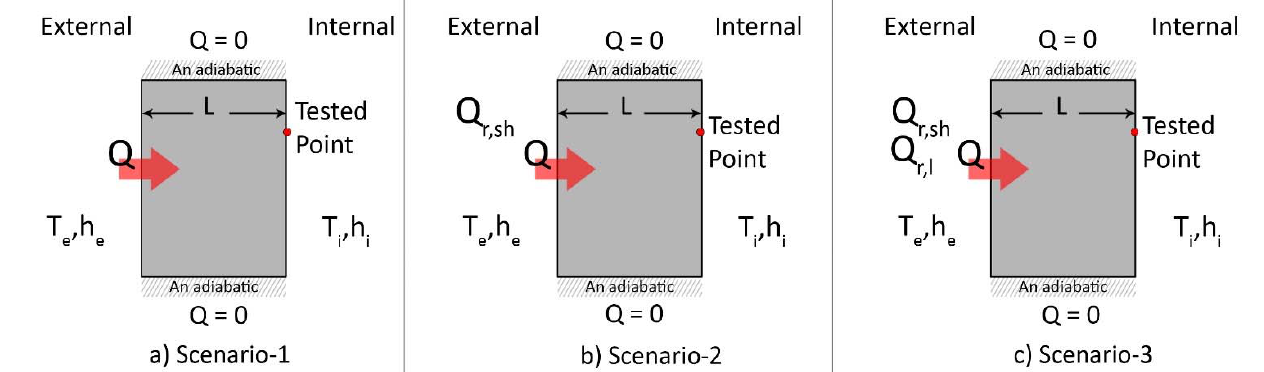
Figure 5. ( a ) Scenario-1 with temperature and heat transfer coefficients only ( left ), ( b ) Scenario-2 with the addition of shortwave radiation ( middle ), and ( c ) Scenario-3 with the addition of longwave radiation ( right